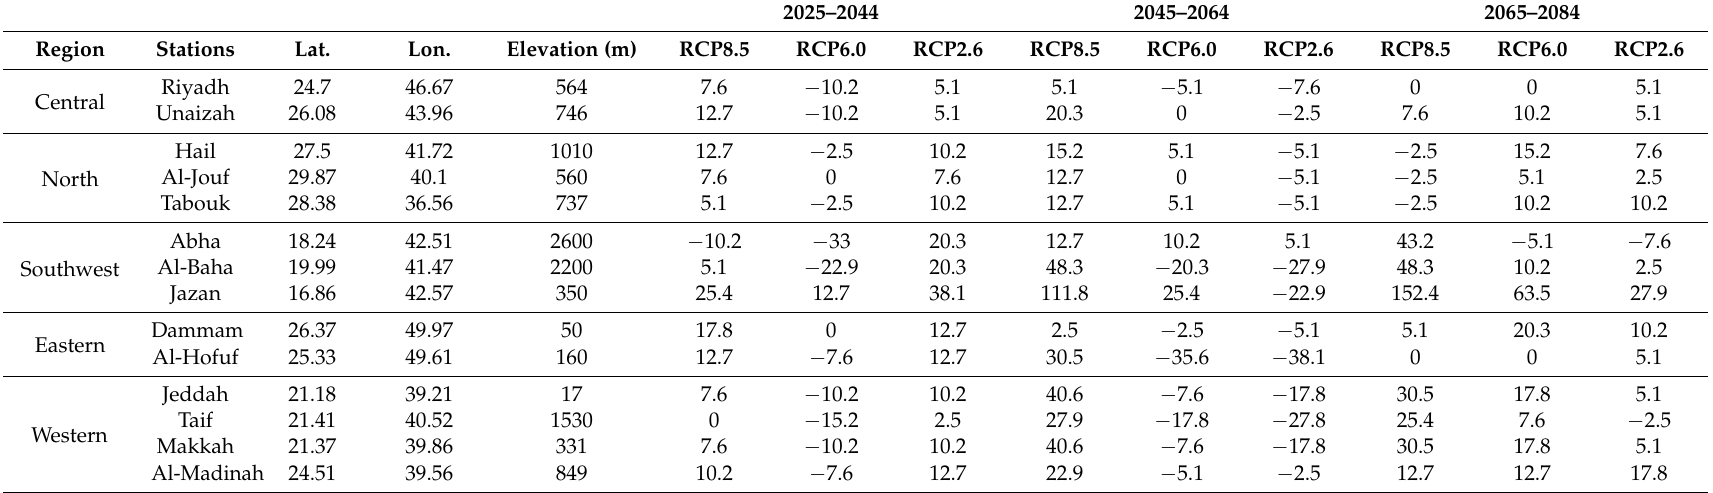
Table 4. Change in rainfall (mm/year) during 2025–2044, 2045–2064 and 2065–2084 from the reference period